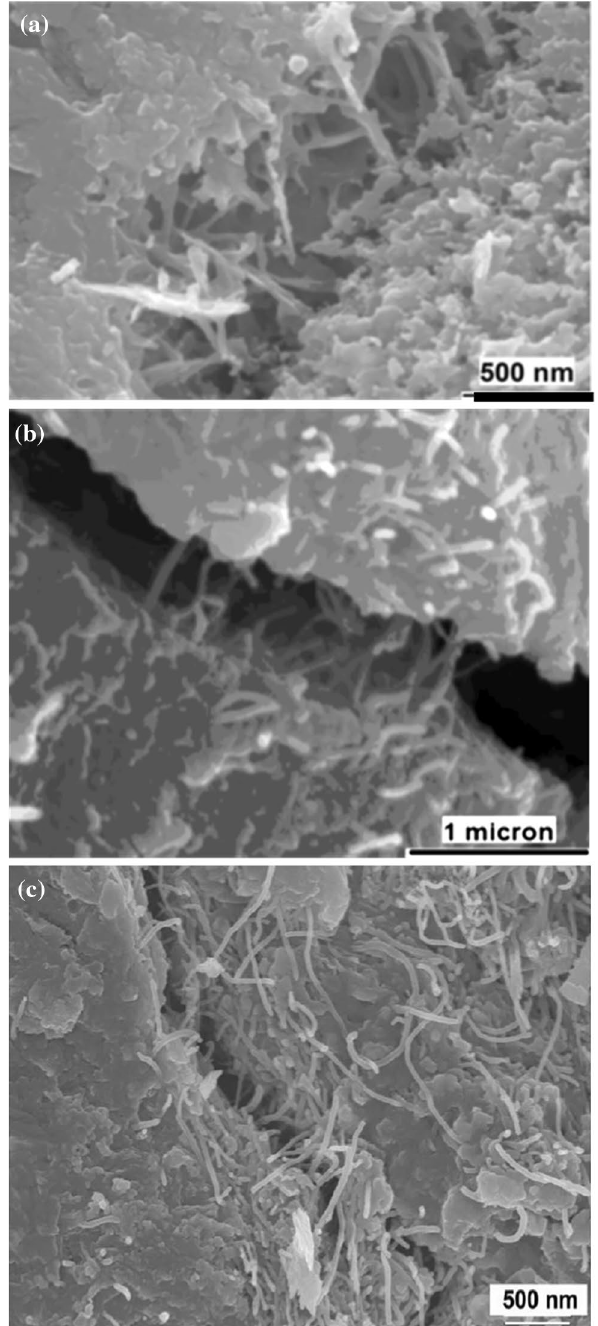
Fig. 11 SEM images showing bridging of micro-cracks by acid- functionalized MWNT-B in UHPCM at 0.03 wt.%